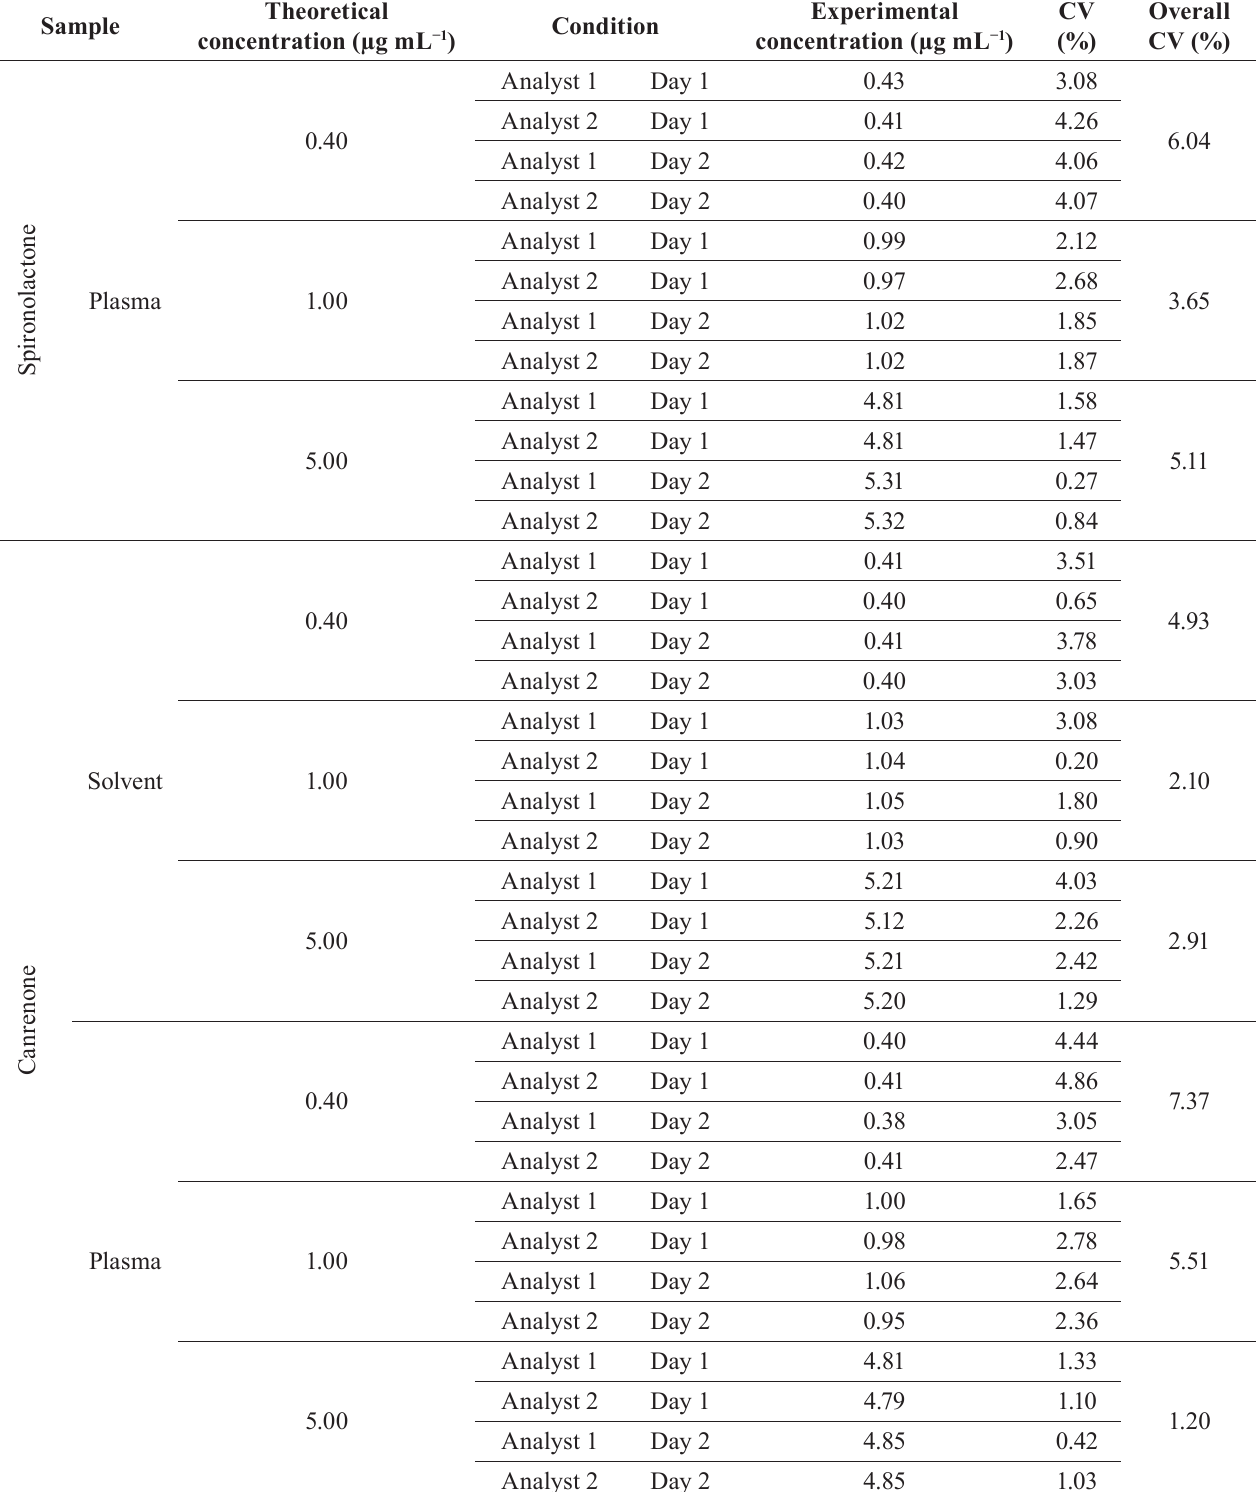
TABLE III – Results of the intra- and interassay precision of the analytical method for quantifying spironolactone and canrenone in methanol and